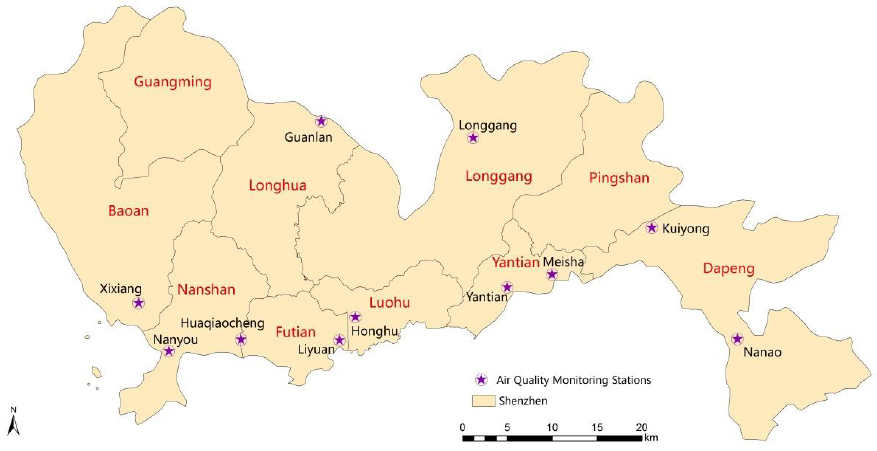
Figure 1. Distribution of state-controlled air quality monitoring sites in Shenzhen.